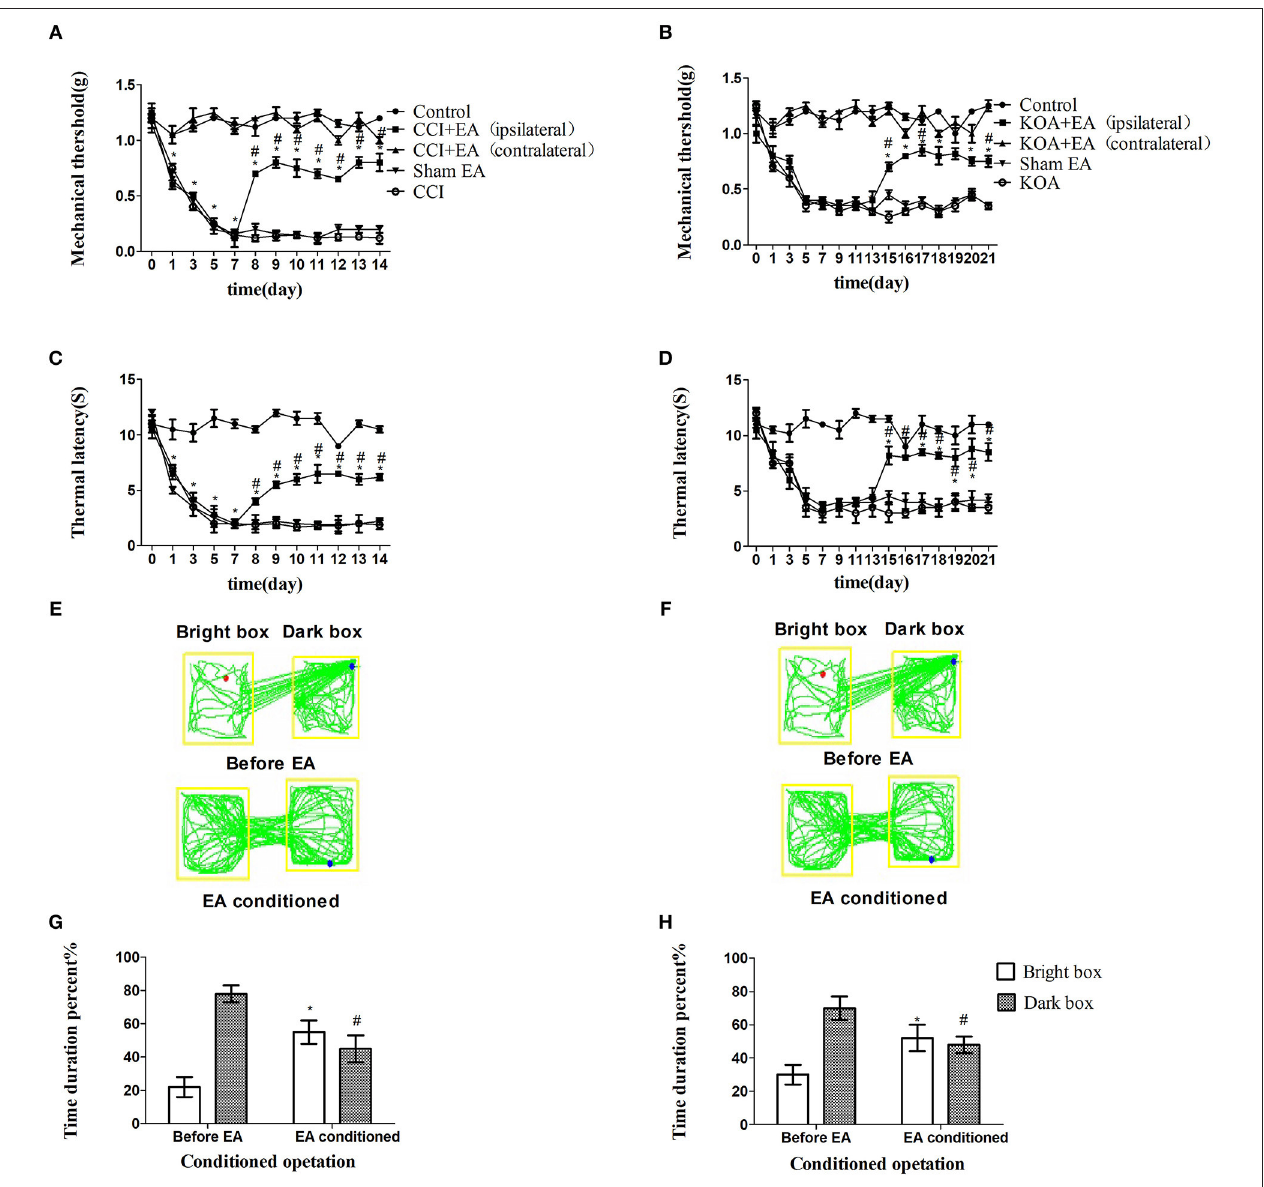
FIGURE 1 | EA effectively reduces pain hypersensitivity in CCI and KOA mice. (A,B) Time course of tactile threshold in response to von Frey filaments. (C,D) The noxious heat stimulus (53 ◦ C) caused a change in the thermal thresholds. The effect of tactile (A) and thermal (C) withdrawal thresholds changes in CCI mice. The change of tactile (B) and thermal (D) withdrawal thresholds of KOA mice caused by EA. A motion map of the EA-conditioned CPP test in CCI (E) and KOA mice (F) . G,H are summary values of motion trajectories. EA (1mA and 0.1ms) at 2Hz was administered for 30min, once a day starting from the 8th to the 14th day in the CCI model and starting from the 15th to 21st day in the KOA model. Control group consisted of sham-operated mice. Data are expressed as the means ± SEM ( n = 12 in each group). In A–D , * p < 0.05, compared with the control group; # p < 0.05, compared with the model group; In panels G,H ,* p < 0.05, compared with the bright box time duration percent before EA; # p < 0.05, compared with the dark box time duration percent before